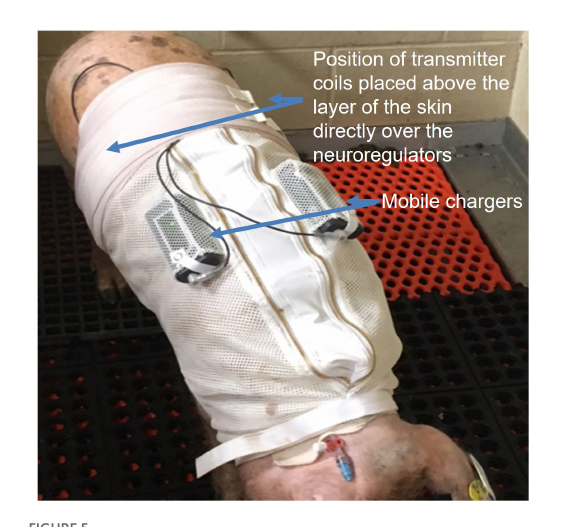
FIGURE5 Alloxan treated Yucatan swine wore a specially designed jacket to house two of the ReShape Lifesciences Inc. Viking mobile chargers. Transmitter coils above the layer of the skin were connected to the mobile chargers to charge the implanted neuroregulators with a RF signal between experiments. Settings for stimulation and high frequency alternating current (HFAC) parameters were also programmed into the neuroregulators using a laptop computer and application software via the mobile chargers and transmitter coils. Swine were trained for 7 days to wear the jacket. During the charging sessions the swine were not restrained and there was no apparent stress to the